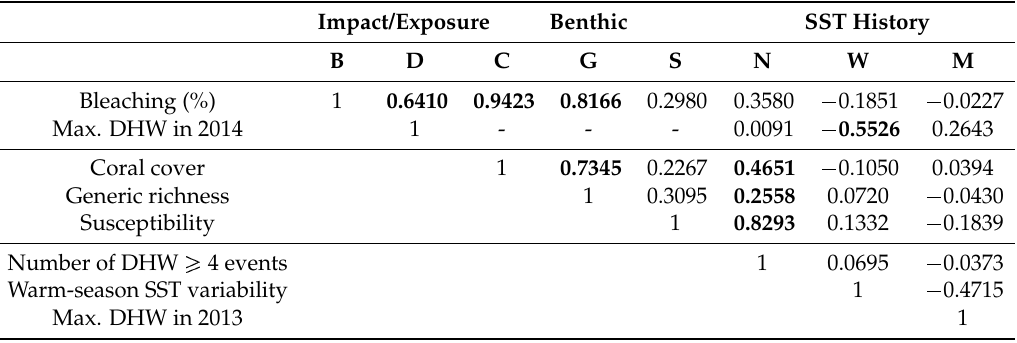
Table 2. Correlations (r) between percent Bleaching (B), Degree Heating Week (DHW) (thermal stress accumulation, D), Coral cover (C), Generic richness (G), Susceptibility (S), Number of (cid:5) DHW ¥ 4 C-week events during 1985–2012 (N), Warm-season sea surface temperature (SST) variability during 1985–2012 (W) and the Maximum 5 km DHW from 2013 (M). All parameters were calculated for each island-and-month grouping ( n = 8). Emboldened numbers are referenced in the text. Where no plausible correlation should be expected, values were not calculated. Impact/Exposure Benthic SST History B